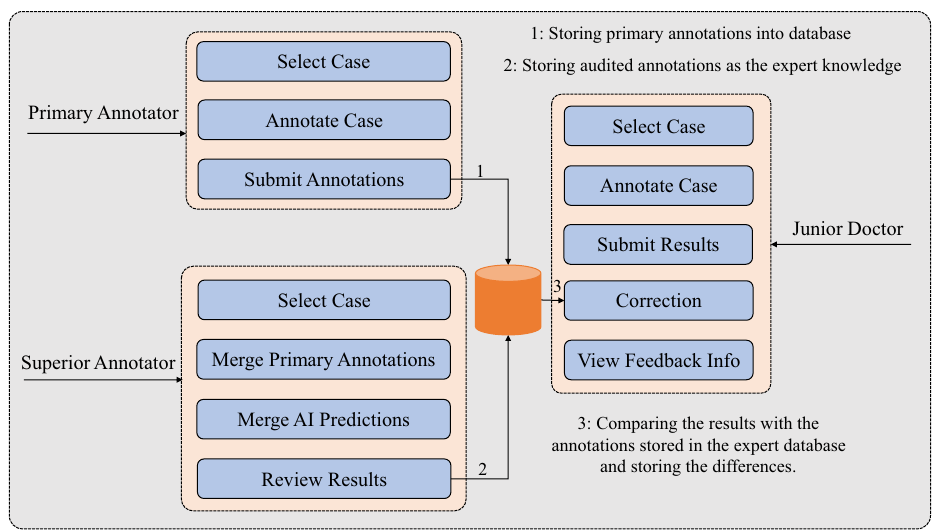
Figure 3. The overview of the three user interfaces. TeachMe provides different functionality for different types of users. The primary annotator users and the superior annotator users take part in the construction of the expert database. The primary annotator users are responsible for giving the primary annotations. The superior annotator users make the final review and confirmation. The annotations audited by superior annotator users are the expert knowledge stored in the expert database. The junior doctor users are the service object of the constructed expert database. TeachMe can correct their submitted “answers” owing to the feedback mechanism of